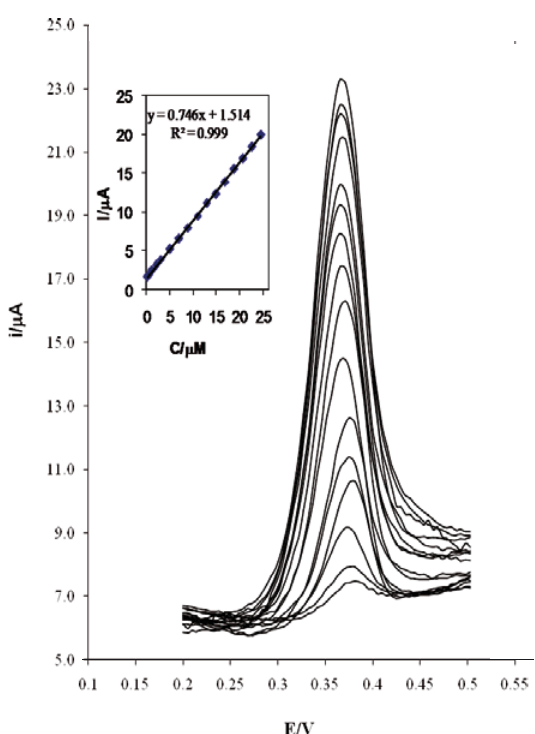
Figure 7. Differential pulse voltammograms of ZMCCE in phosphate buffer solution pH 7 containing different concentrations of Piroxicam from 0.20 to 25.00 μ M. Inset: dependence of the increasing value of peak current on concentration of Piroxicam added in the